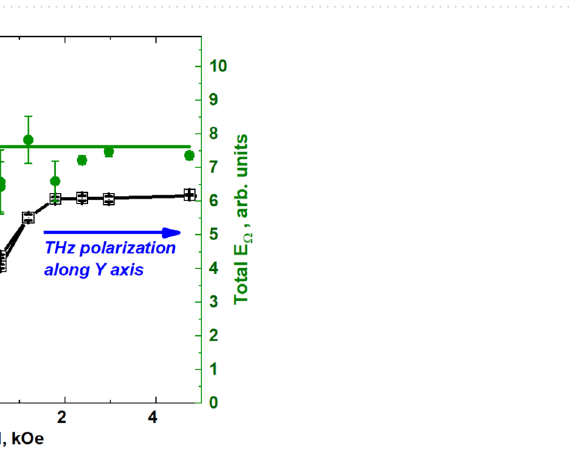
Figure 3. Angular diagram (peak-to-peak THz amplitude as a function of ϕ 2 ) for different orientations of the wire grid polarizer and different values of magnetic field in the “hard axis” geometry. The scale is the same for all polar dependences. Lines are fits to data using by Eq. (S4) from Supporting Information file. Sketch on bottom shows corresponding directions of THz wave polarization. The direction of magnetization is shown on the sample with a green arrow and denoted by the letter M . The direction of application of the magnetic field is denoted as H . The THz field is always perpendicular to the magnetization M .